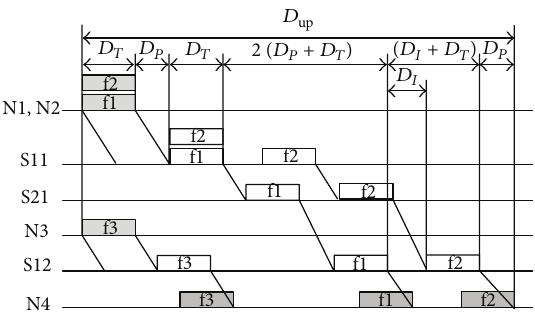
Figure 5: The timing diagram of a two-level switched